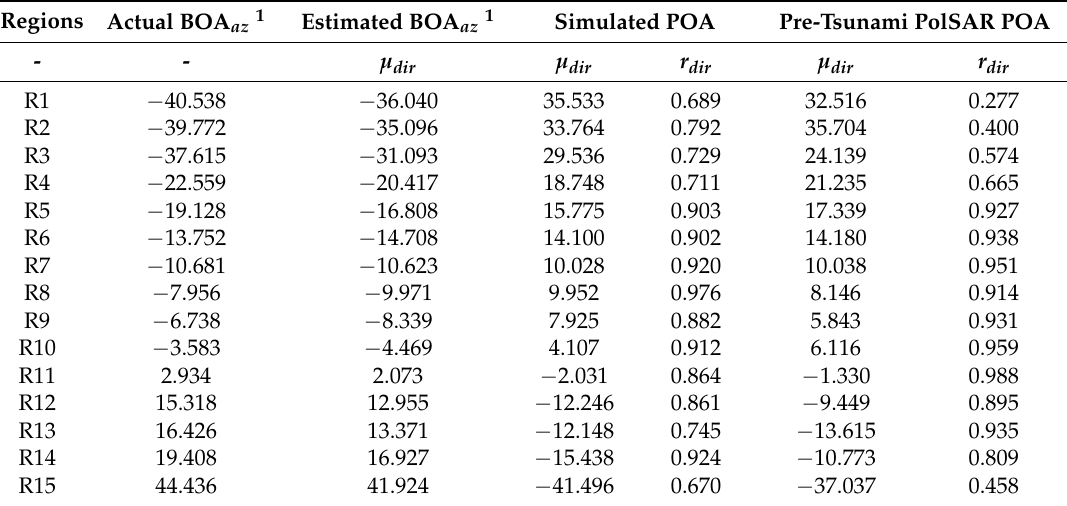
Table 2. Comparison of the simulated polarization orientation angles (POAs) and the pre-tsunami PolSAR POAs (°).